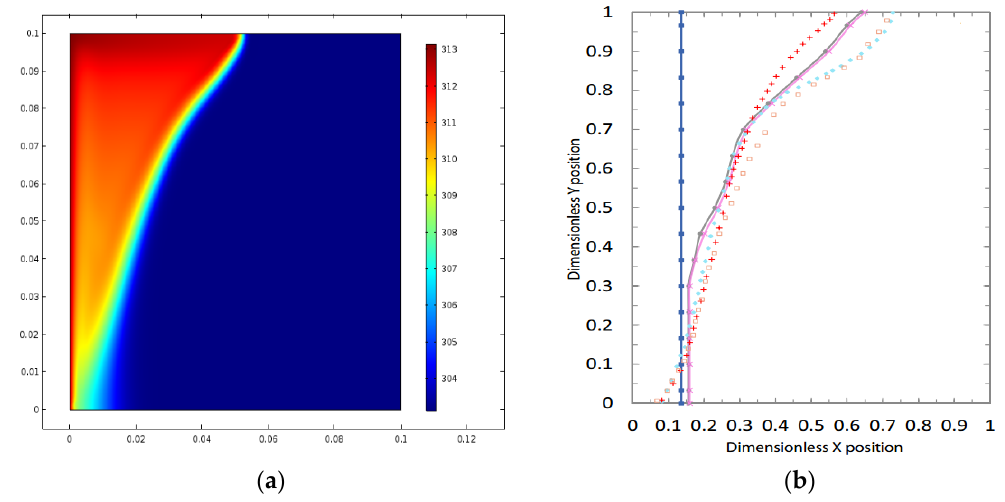
Figure 6. COMSOL results ( a ) and comparison with available data from literature ( b ) [29].